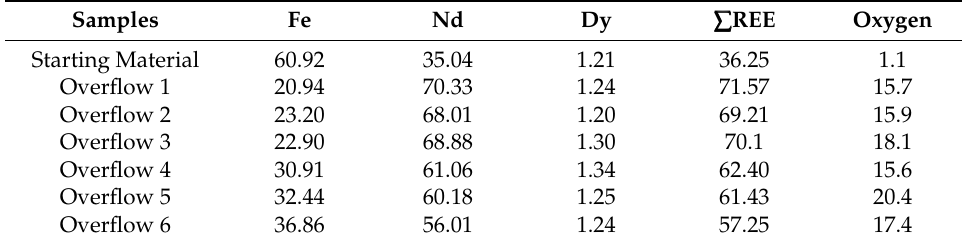
Table 5. Chemical analysis of overflow streams in weight %.